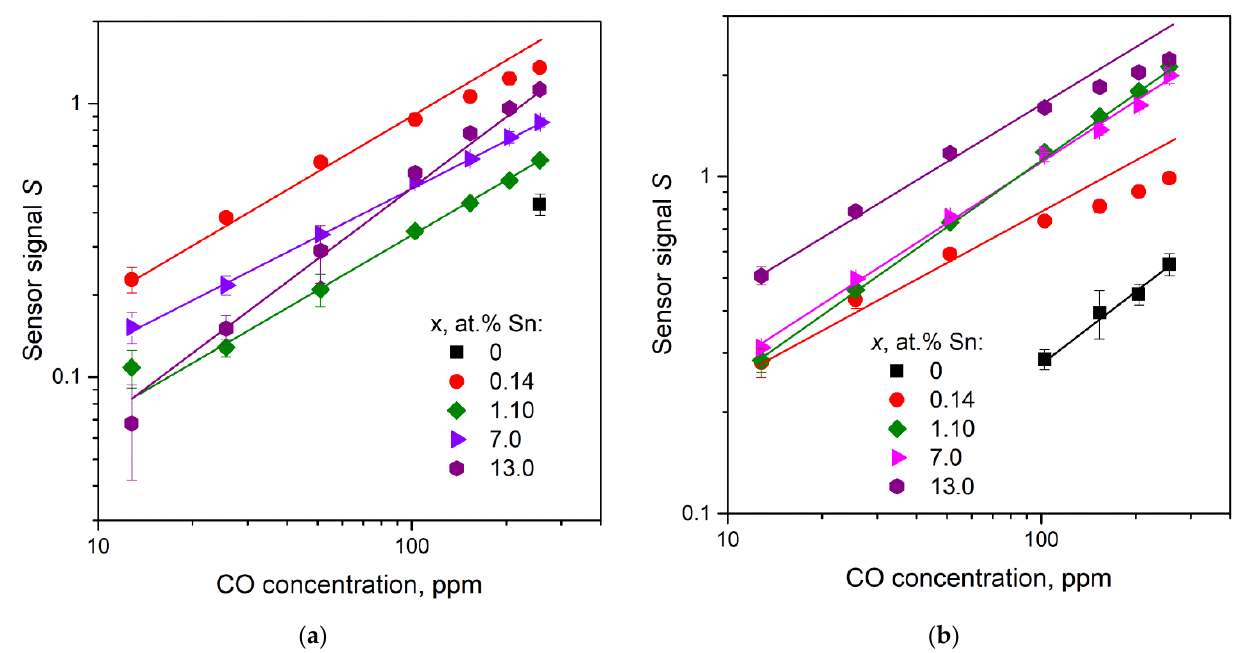
Figure 13. Sensor signal S as a function of CO concentration for Ga 2 O 3 (Sn) samples annealed at 750 ( a ) and 1000 °C ( b ). The measuring temperature is 500 °C.